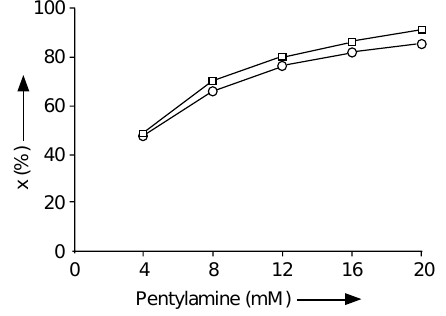
Figure 13 - Influence of pentyla- mine concentration on the prod- uct yield x of the clostripain-cata- lyzed coupling of Y-OGp with pentylamine (46). Circles, Y = Bz; squares, Y = Pbu. Condi- tions: 0.2 M HEPES-buffer, pH 8.0, 0.1 M NaCl, 10 mM CaCl 2 , 5% DMF, 25 o C; [acyl donor]: 2 mM; reaction time: about 15